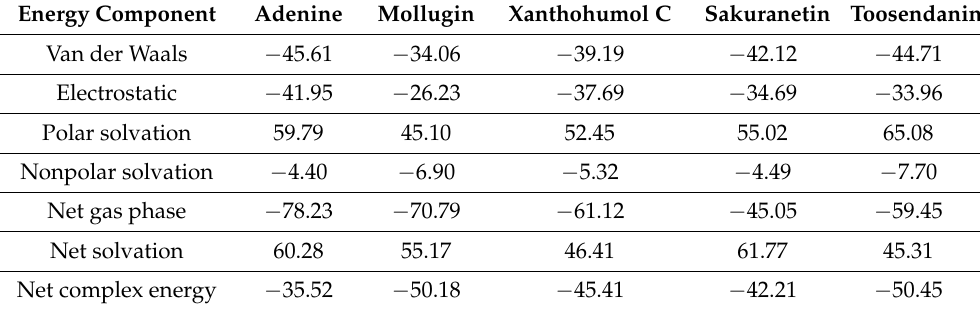
Table 4. Binding energies of best docked compounds.